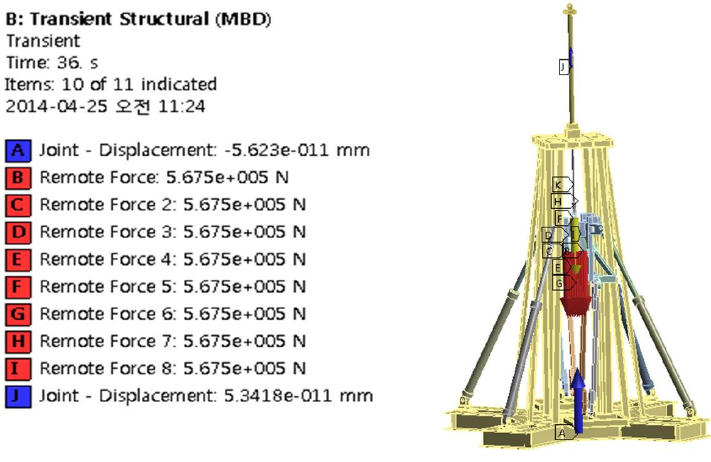
Figure 5. Boundary condition of multi-body dynamics.